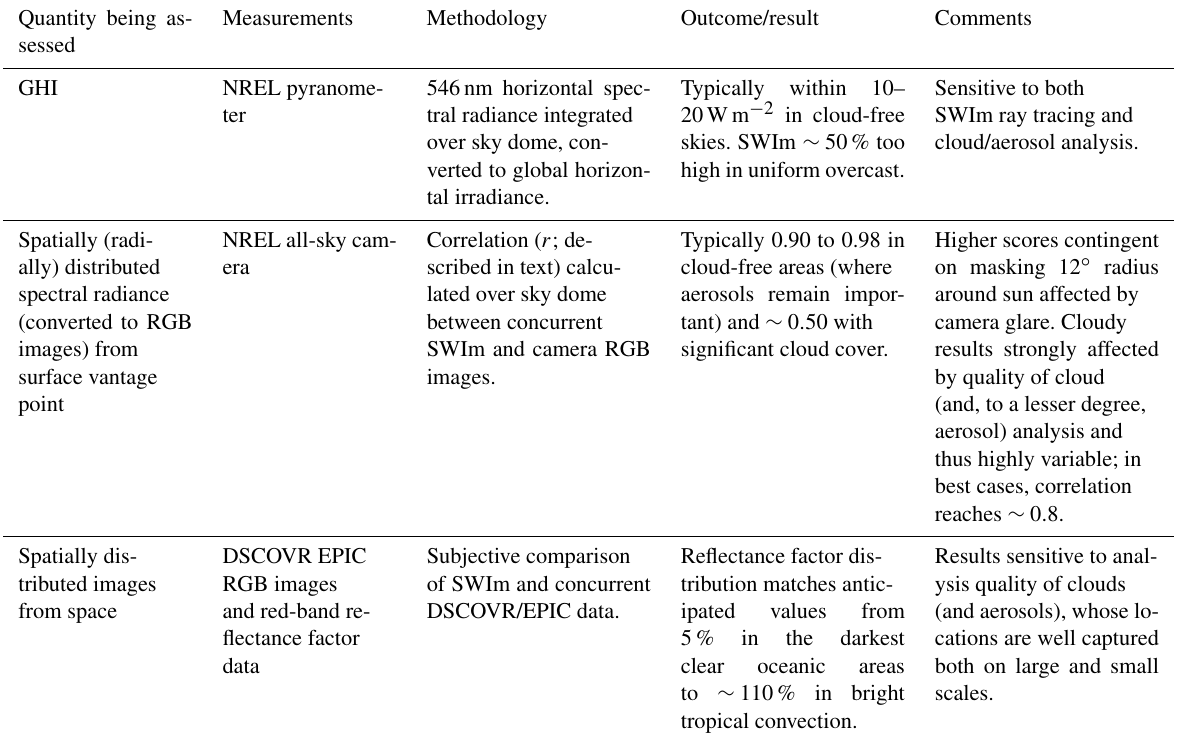
Table 4. List of SWIm validation methods being developed.